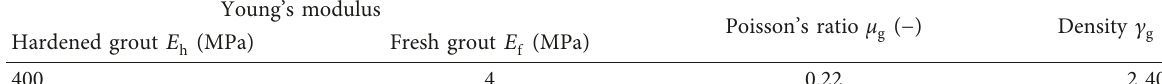
Table 1: Parameters of the grout.